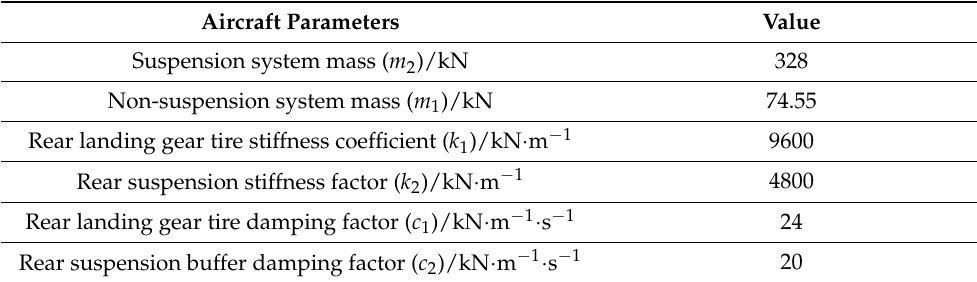
Table 1. Parameters of B737-800